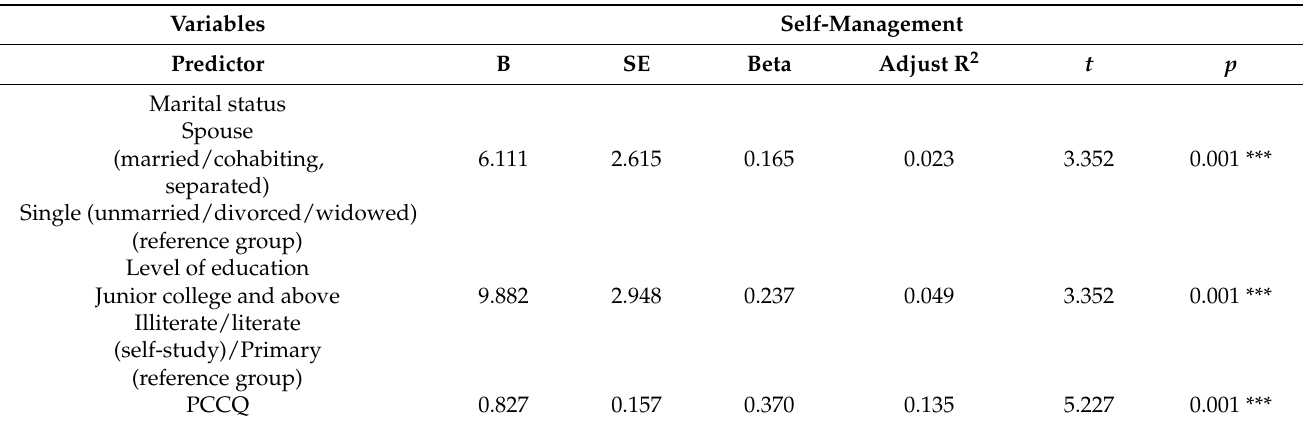
Table 4. Important predictive variables of the self-management of patients with type 2 diabetes ( N =